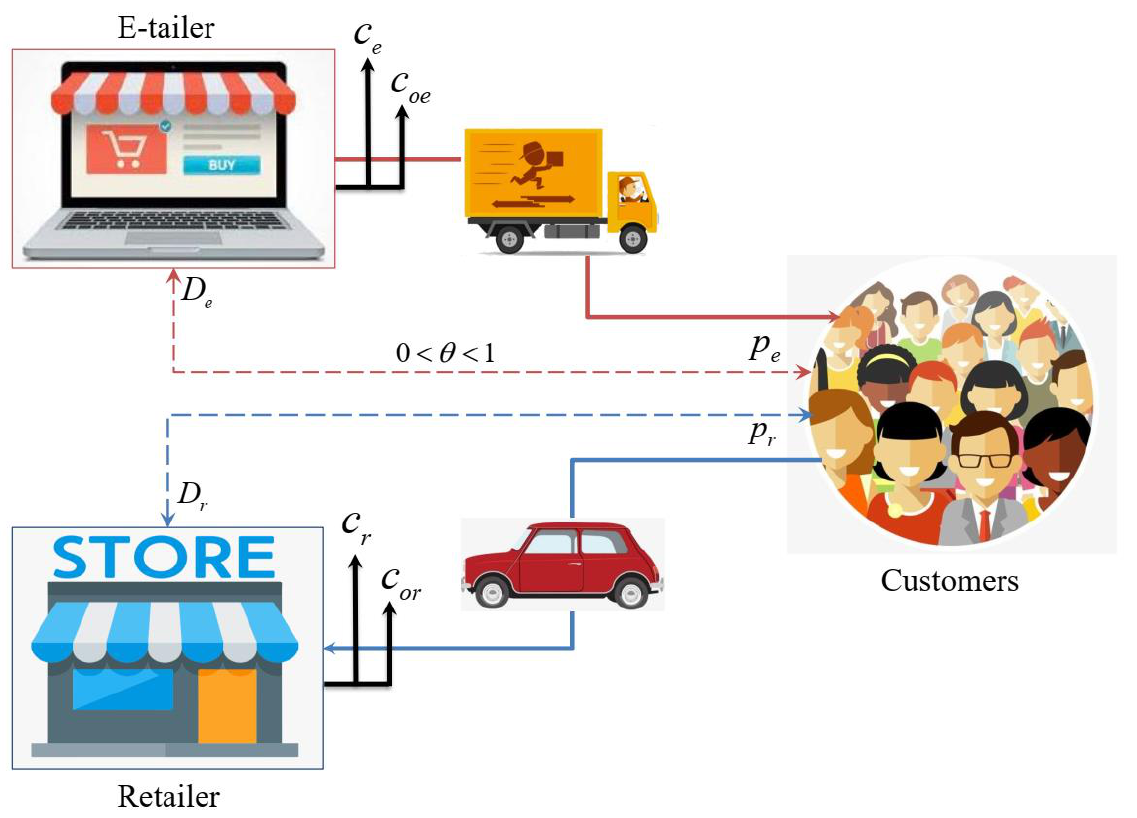
Figure 2. Emission-sensitive supply chain.